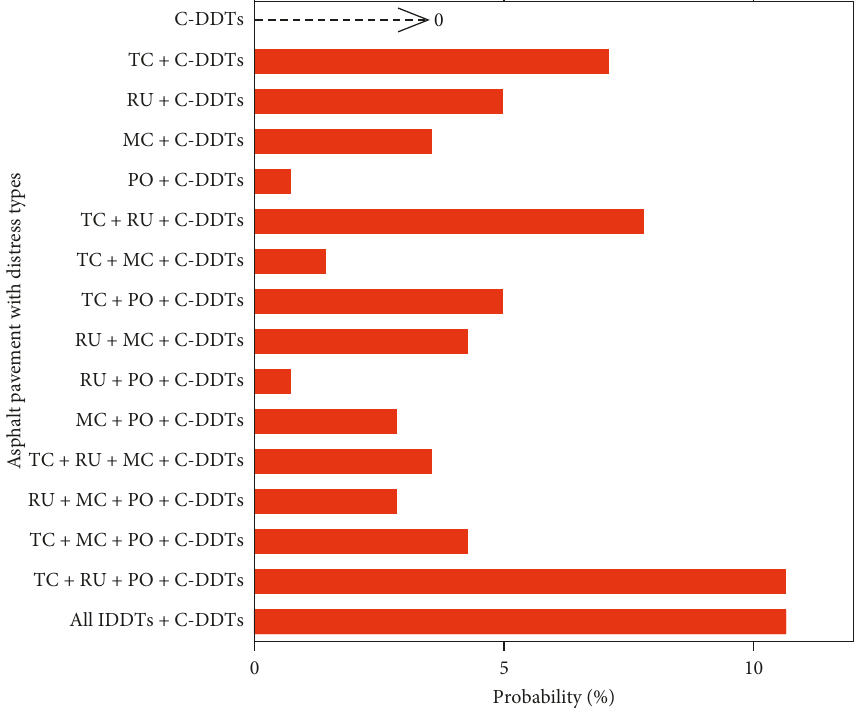
Figure 4: Proportions of asphalt pavements with different combinations of IDDTs and DDTs.